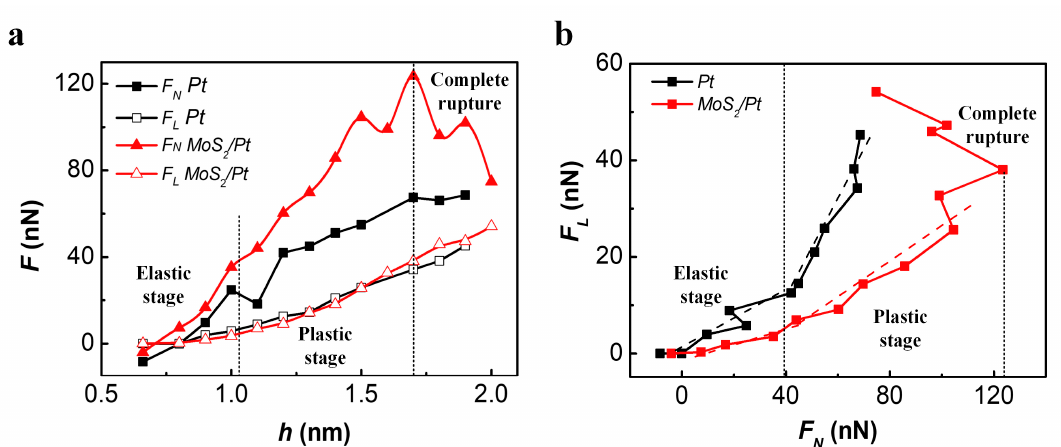
Figure 5. ( a ) Average load and friction varied with indentation depth during the scratch process of MoS 2 /Pt and bare Pt substrates; ( b ) The relation between average load and friction for MoS 2 /Pt and bare Pt substrates. Dashed line in ( b ) is a linear fitting of F L and F N .